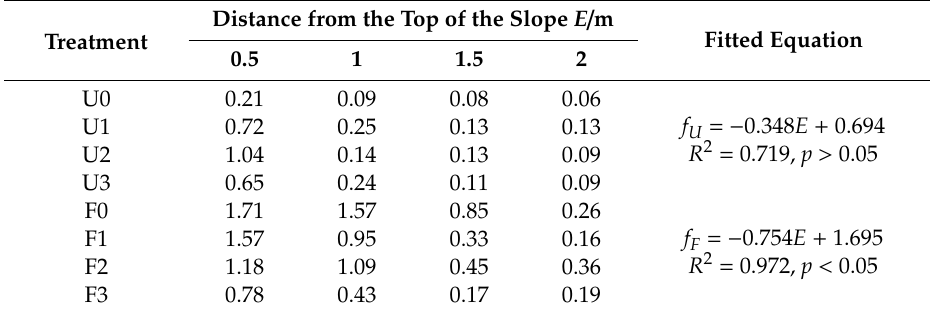
Fitted Equation